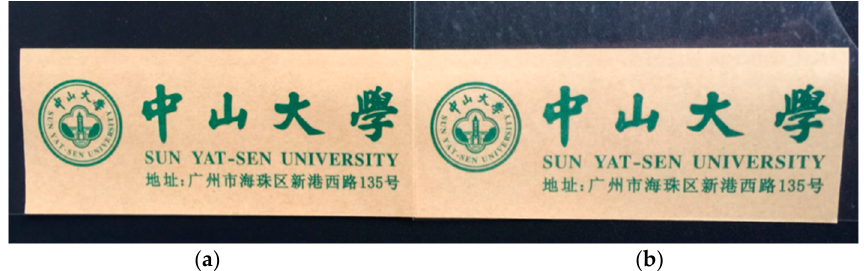
Figure 14. Nanobrick wall structure resulting from qualdlayer assembly of PAA (green), PDDA (orange), ZrP (blue).